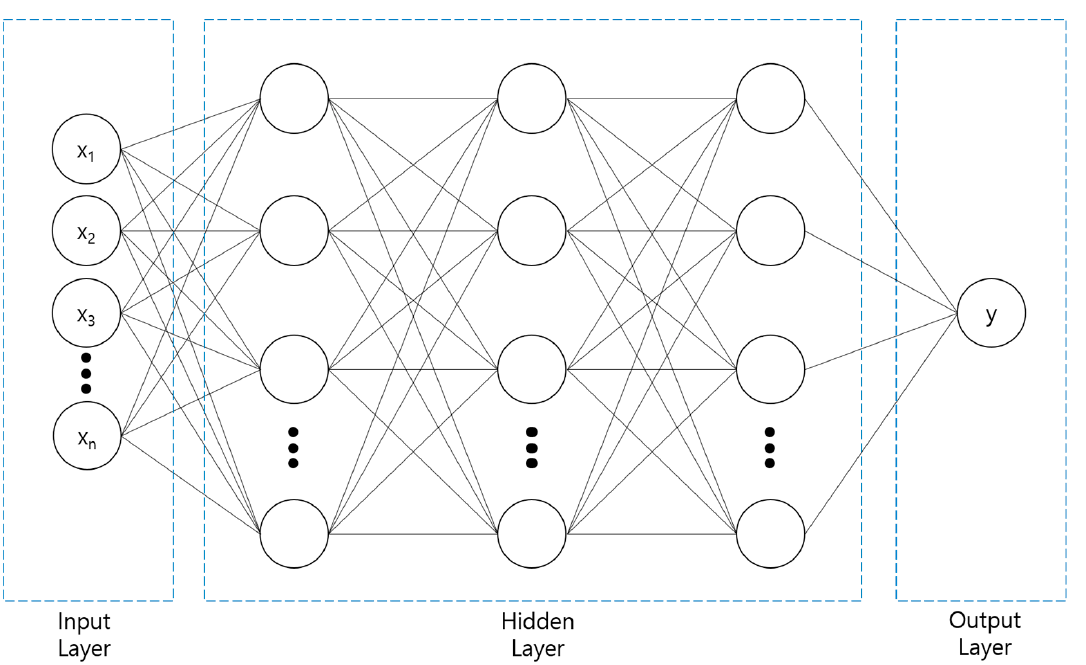
Figure 7. Illustration of a DNN with three hidden layers.